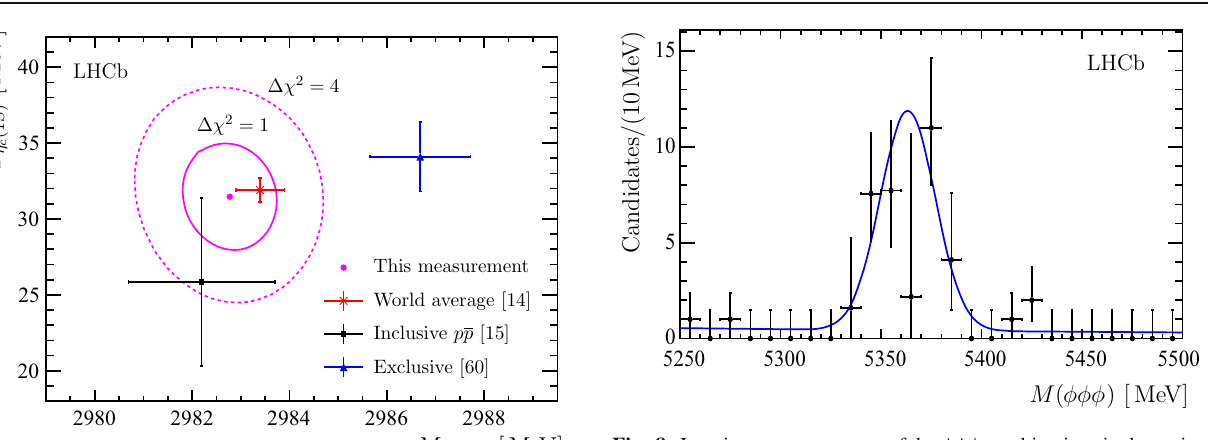
Fig. 8 Invariant mass spectrum of the φφφ combinations in the region of the B 0 s mass, including the fit function described in the text Fig. 7 Contour plot of (cid:8) η and M η using η c → φφ decays. c ( 1 S ) c ( 1 S ) The two magenta curves indicate (cid:12)χ 2 = 1 and (cid:12)χ 2 = 4 contours. Only statistical uncertainties are shown. The red cross , black square and blue triangle with error bars indicate the world average [14], the result from Ref. [15], and the result from Ref. [61], respectively